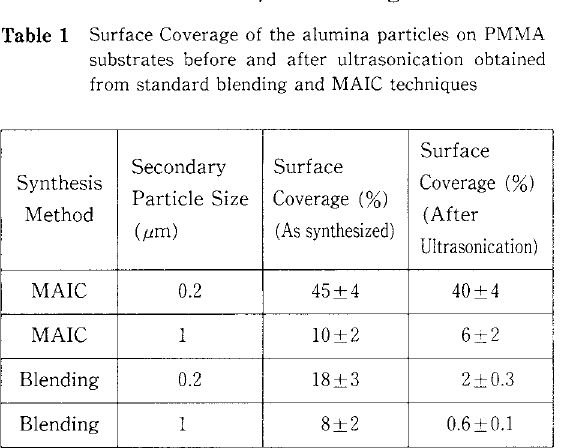
Table 1 Surface Coverage of the alumina particles on PM:VIA substrates before and after ultrasonication obtained (b)